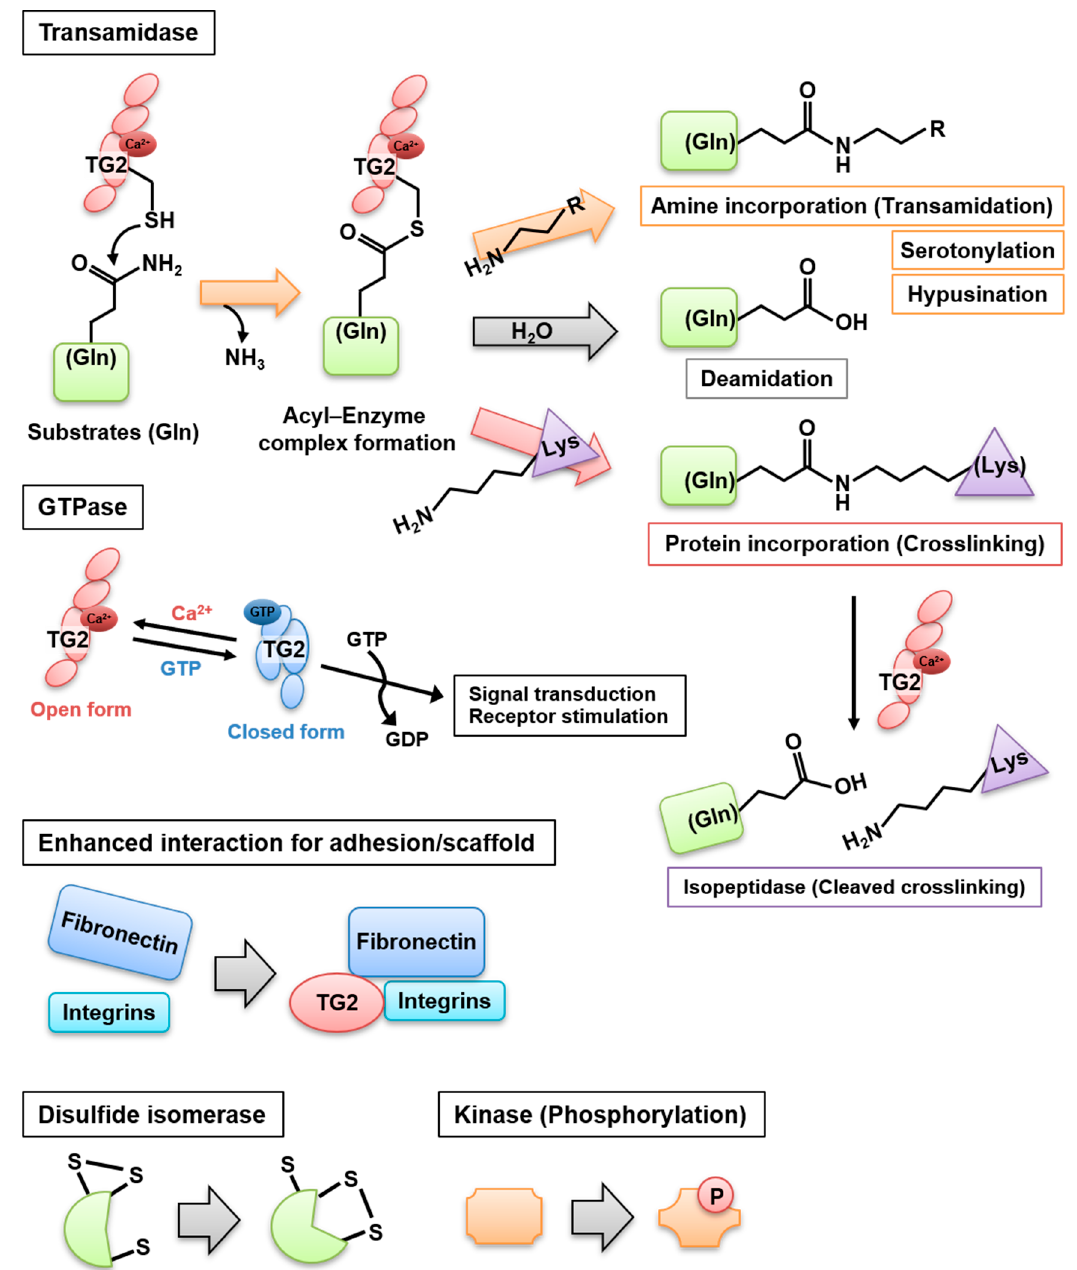
Figure 1. TG2 multifunctional roles. TG2 contributes to the posttranslational modification of several substrate proteins via multiple mechanisms, acting as a transamidase, deamidase, crosslinking protein, isopeptidase, GTPase, adhesion/scaffold protein, disulfide isomerase, and kinase. The mechanisms of some TG2 functions remain unclear. Thanks to its multiple roles, TG2 exerts various biological functions depending on the stimulus, leading to cell death or survival and tissue repair.